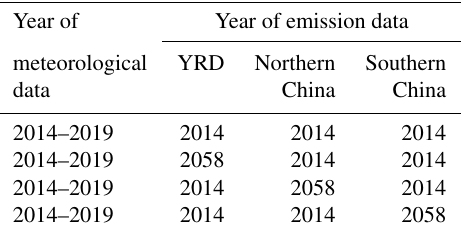
Table 1. Last 6 years of the nudged UKESM1 simulation for 1999–2019 (with CMIP6 historical emissions for year 2014) and three sensitivity simulations with reduced emissions (for year 2058 according to the CMIP6 SSP3-7.0 scenario) over YRD, northern China, and southern China, respectively. The three regions are dis- played in Fig.